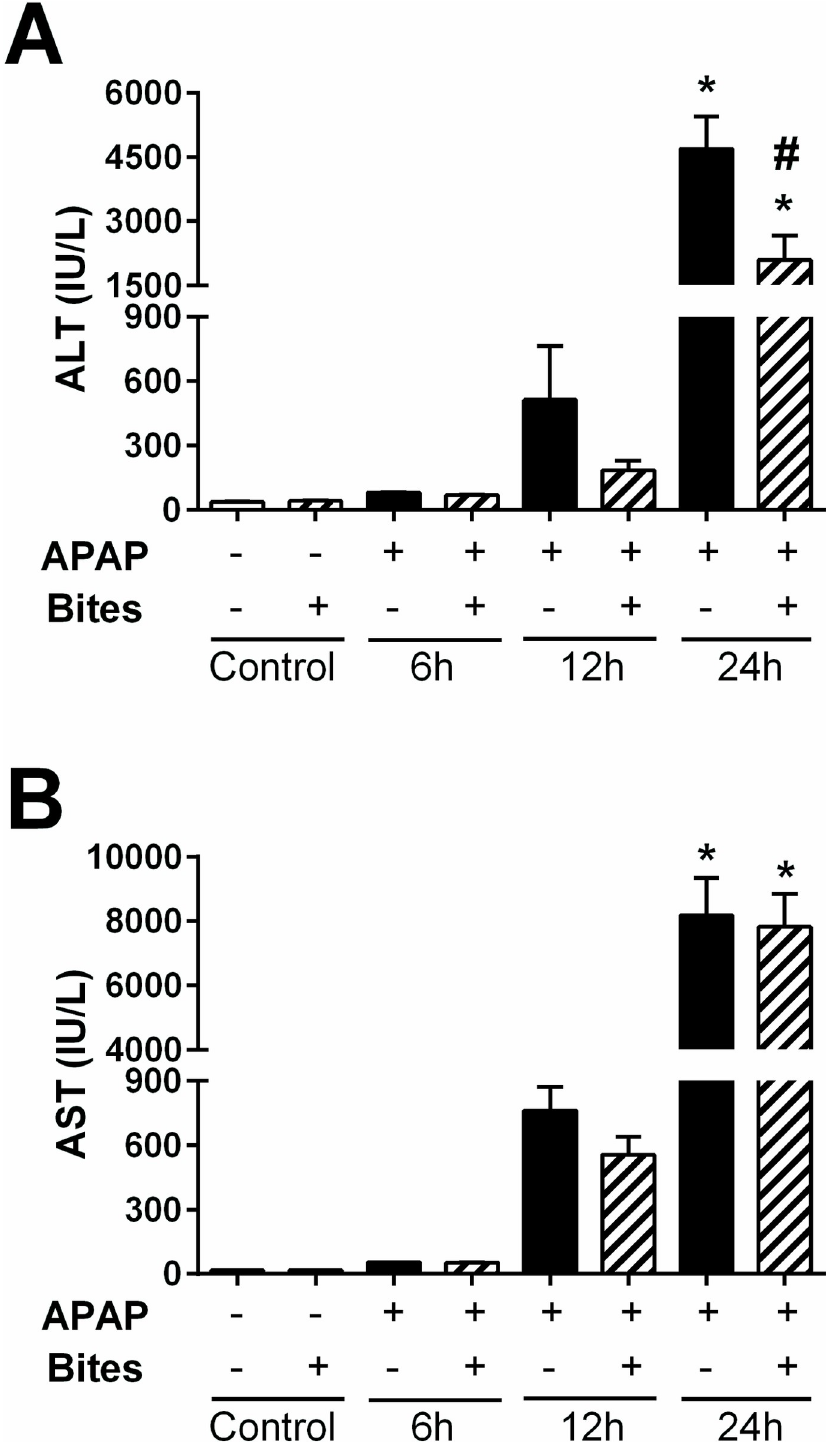
Fig 1. Serum levels of ALT and AST in mice injected with APAP and exposed to Ae . aegypti mosquito bites. C57BL/6 male mice were injected with PBS or APAP (300 mg/kg i.p.) and, after 2 hours, exposed to 30 Ae . aegypti mosquitoes. Transaminase levels were measured in samples collected 6, 12 and 24 hours after PBS or APAP injection. A. ALT levels; B. AST levels. The data represent the mean ± SEM ( n = 4–12). � p < 0.05 versus “PBS” group; # p < 0.05 versus “APAP” group at 24 h after